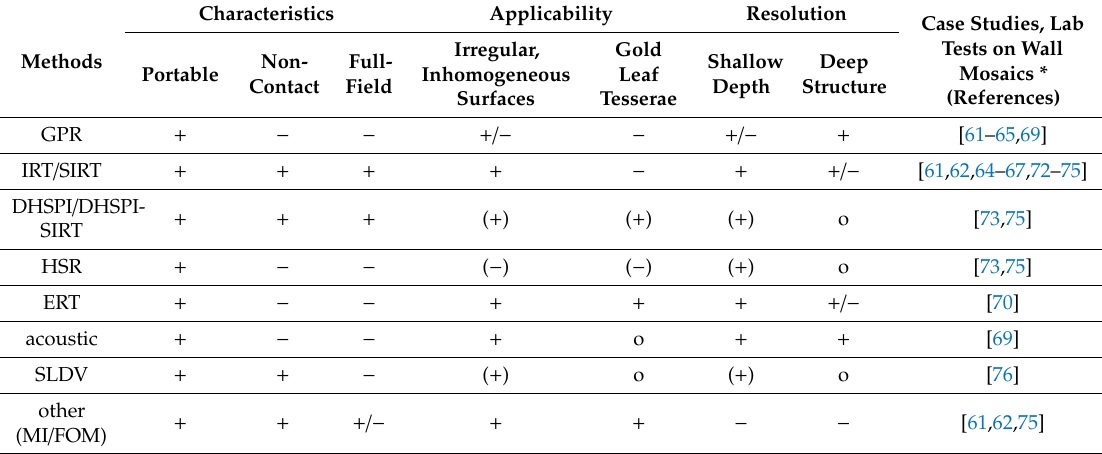
Table 1. Applicability of non-invasive techniques on wall mosaics